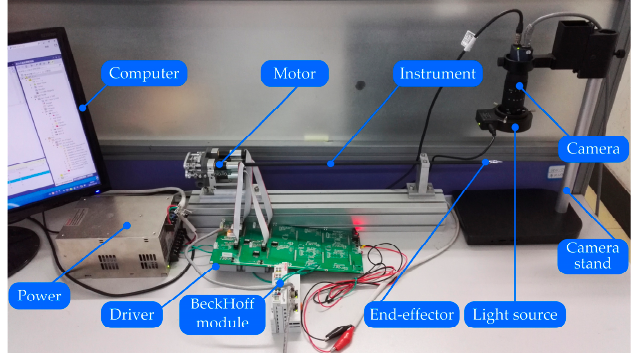
Figure 9. Photo of experimental setup.